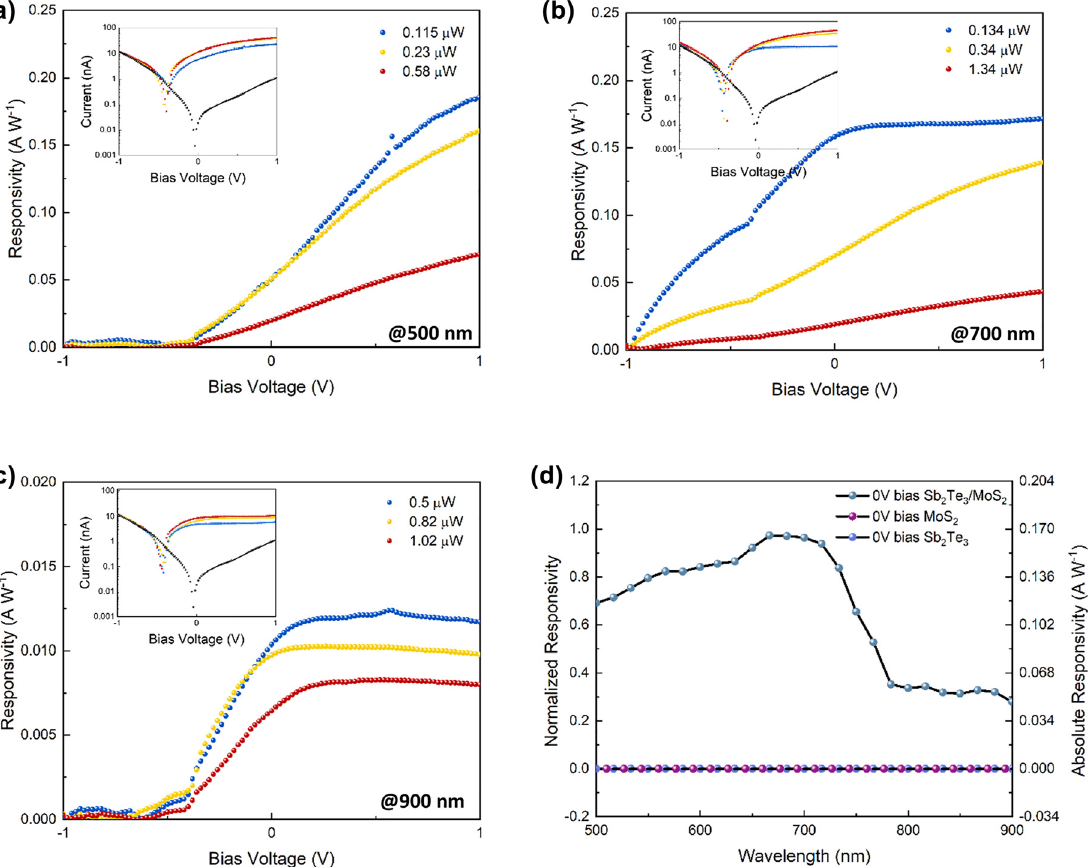
Te /MoS PN junction heterostructure photodetector. (a), (b), (c) The measured photoresponsivity Figure 3: Electrical characterization of Sb 2 3 2 at different wavelengths, 500 nm, 700 nm, and 900 nm, under − 1 to 1 V bias voltage. At zero bias, the photoresponsivity was clearly observed and increased proportionally to the optical power. (d) Normalized responsivity by sweeping the wavelength under 0 bias from 500 to 900 nm with a step size of 10 nm, which indicates a broad wavelength